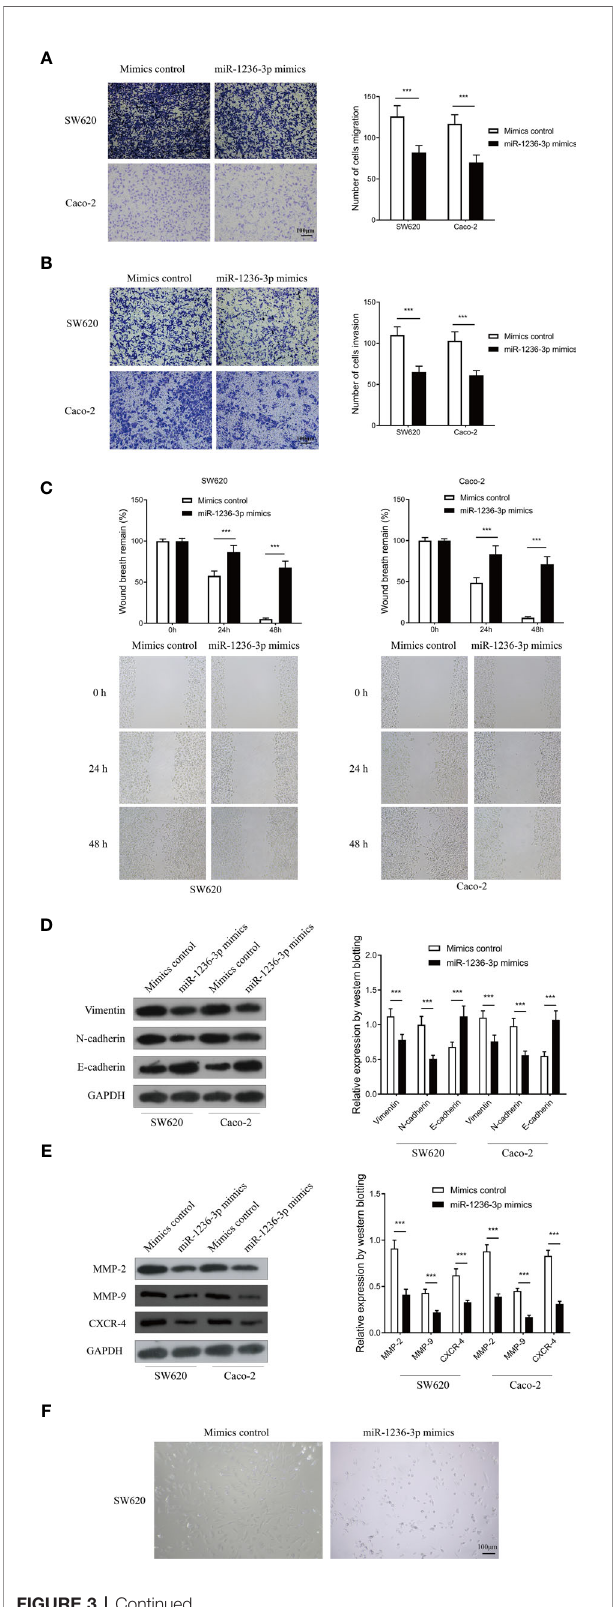
FIGURE 3 | MiR-1236-3p inhibited colon cancer invasion and migration in vitro . Transwell migration (A) and invasion (B) assays in SW620 and Caco-2 cells transfected with miR-1236-3p mimic or mimic control. Scale bar: 100 m m (C) Wound-healing assay at 0, 24, and 48 h in SW620 and Caco-2 cells transfected with miR-1236-3p mimic or mimic control. (D) Western blotting analysis of E-cadherin, N-cadherin, and vimentin in SW620 cells transfected with miR-1236-3p mimic or mimic control. (E) Western blotting analysis of MMP-2, MMP-9, and CXCR-4 in SW620 cells transfected with miR-1236-3p mimic or mimic control. (F) Morphologic changes in SW620 cells transfected with miR-1236-3p mimic or mimic control by inverted microscope. Scale